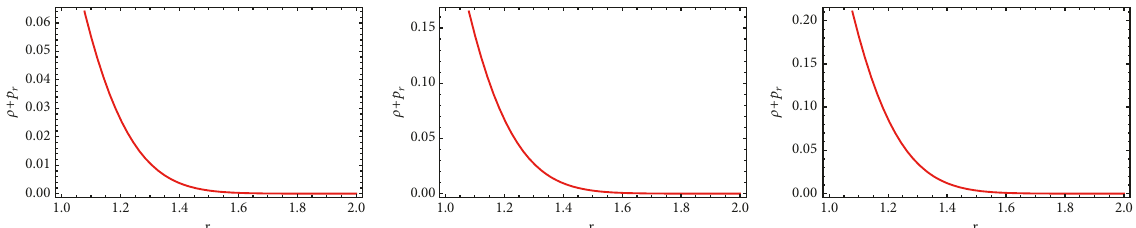
1.0 Figure 4: This figure represents the variation of 𝜌 + 𝑝 𝑟 versus 𝑟 (km) for the strange star taking 𝛽 = 1 , 𝛽 = 2 , and 𝛽 = 3 .